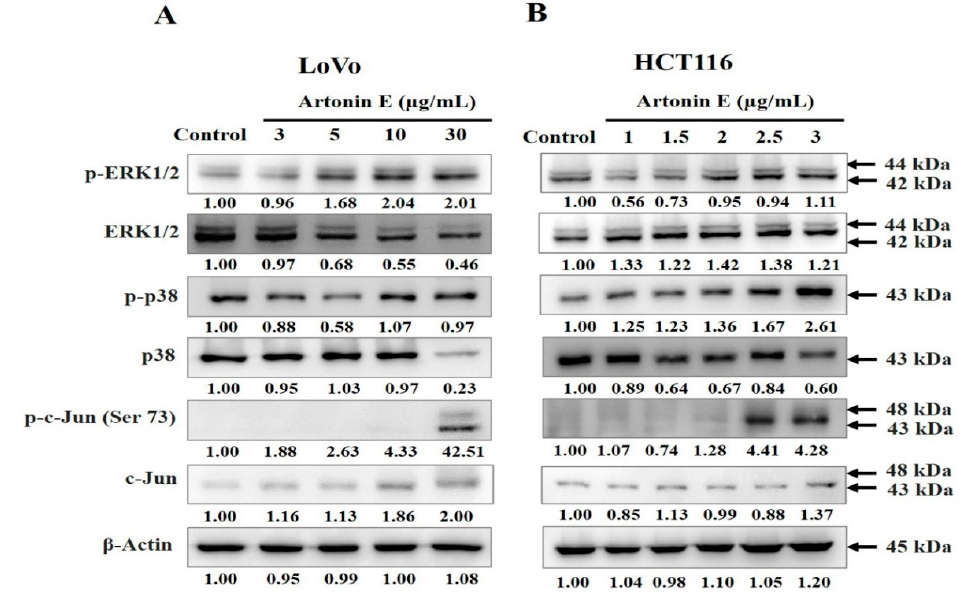
Figure 6. Effect of artonin E on the phosphorylation of MAPK signaling in LoVo and HCT116 cells. Artonin E induced the increased expression of p-ERK1/2, p-p38/p38, and p-c-Jun (Ser73) of ( A ) LoVo cells and ( B ) HCT116 cells, determined by western blot analysis ( p < 0.05).